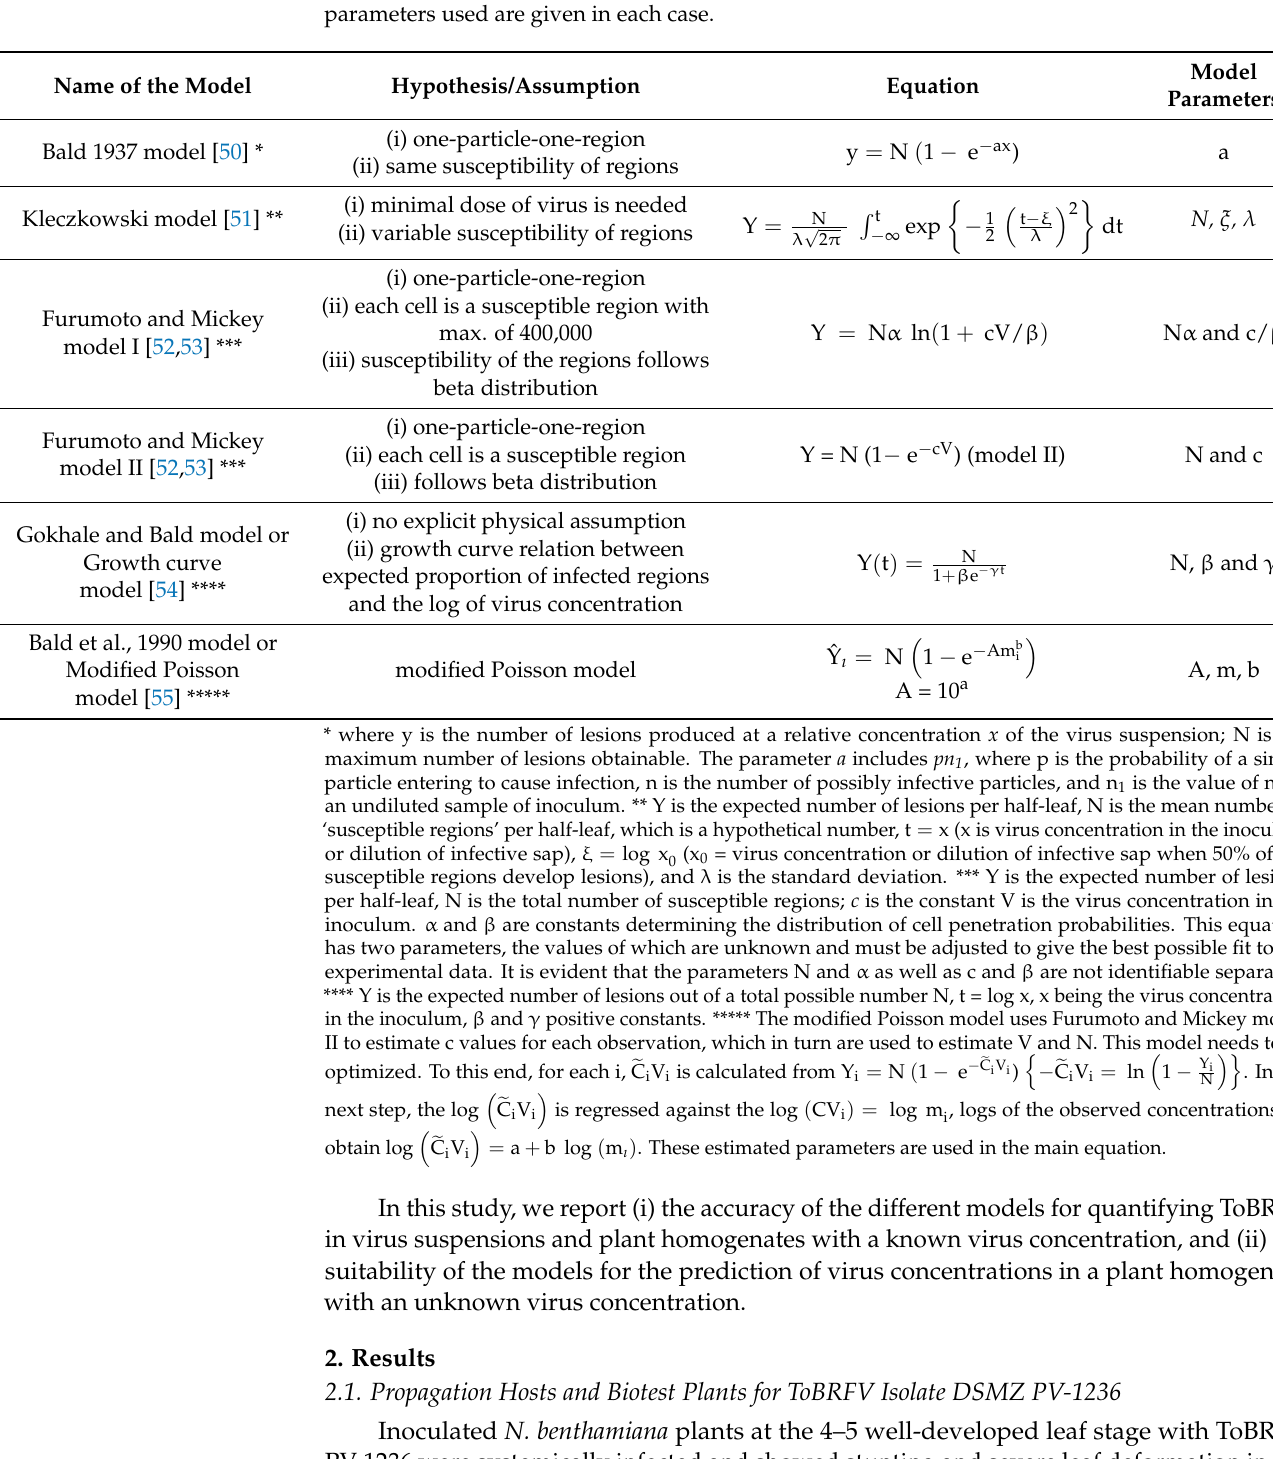
Table 1. Overview of different models used for correlation of virus concentration in the inoculum and number of local lesions produced after inoculation. The equation and an explanation of the parameters used are given in each